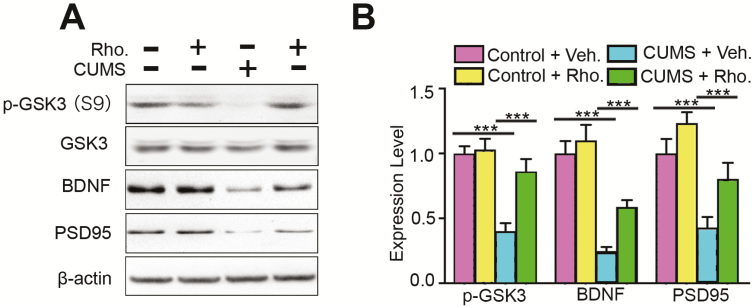
Rhodomyrtone treatment reversed chronic unpredictable mild stress (CUMS)-decreased postsynaptic density protein 95 (PSD-95)/brain-derived neurotrophic factor (BDNF) expression. (A) glycogen synthase kinase-3β (GSK3β), BDNF, and PSD-95 expression in hippocampal tissues was analyzed in all groups. β-Actin was the loading control for samples. Rhodomyrtone increased CUMS-suppressed GSK3β p-GSK3β phosphorylation. Rhodomyrtone treatment reversed PSD-95 and BDNF expression in CUMS hippocampus. (B) Quantification of PSD-95 and BDNF was normalized to the β-actin. Quantification of the p-GSK3 was normalized to the total GSK3. n=9 for all groups; data are presented as mean±SEM; *P<.05; **P<.01; ***P<.001.